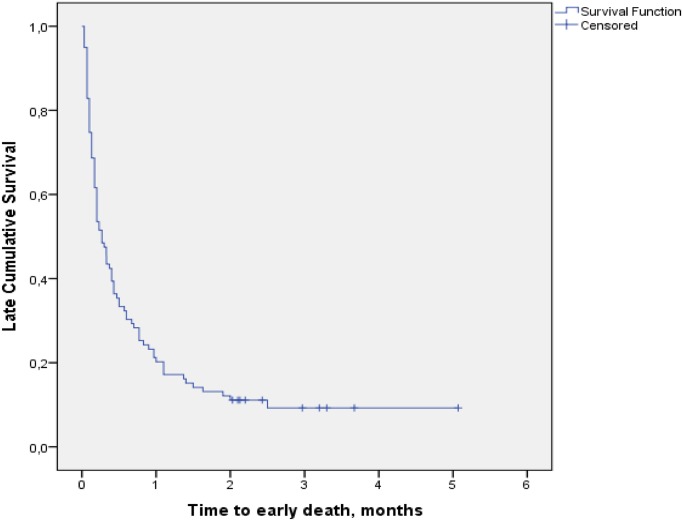
Kaplan-Meier survival curve of cumulative survival over time during tuberculosis treatment of patients co-infected with HIV.